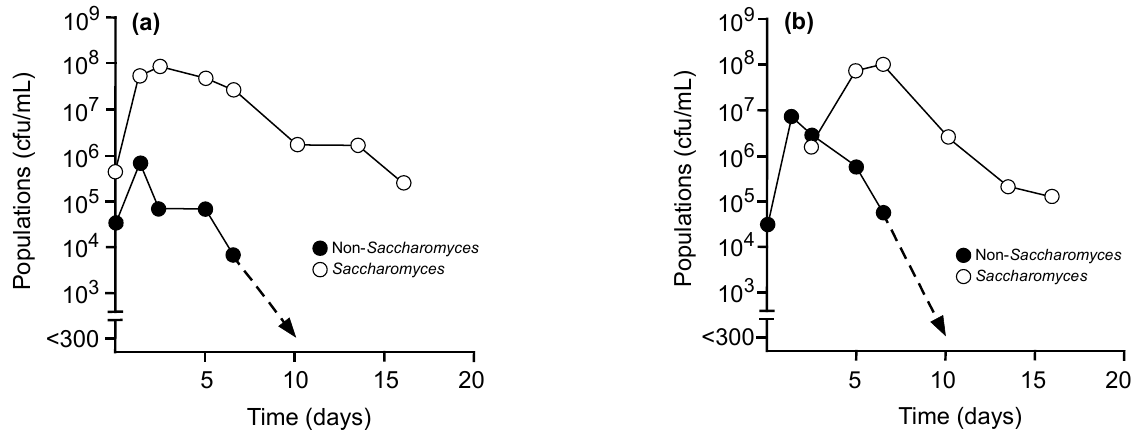
Figure 1. Culturable populations of uninoculated with non- Saccharomyces yeasts ( ● ) but with Saccharomyces cerevisiae ( ○ ) inoculated either on day 0 ( a ) or day 3 ( b ) in Merlot grape musts.